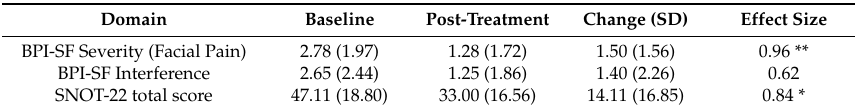
Table 3. Treatment results for patients with baseline pain ( n = 9). Mean scores, SD, mean change in scores, effect sizes (Cohen’s d ) and p -values are included.